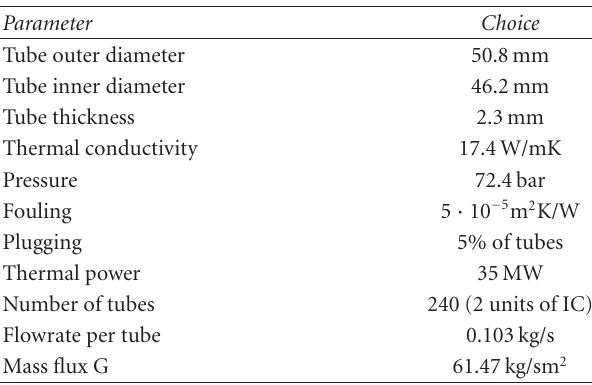
Table 1: IC data, taken as reference for the